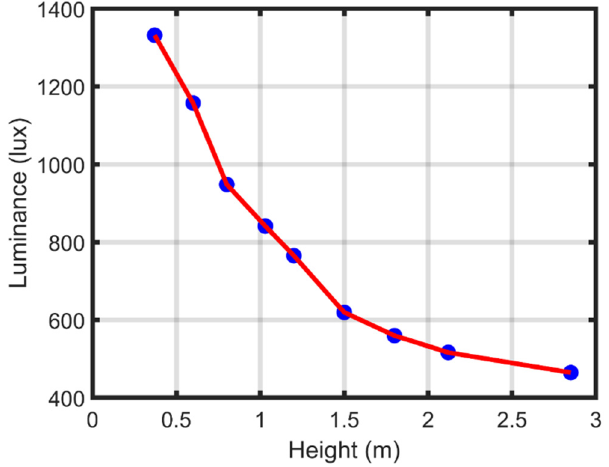
Figure 6. LED light intensity distribution ( 𝜇 = 0, 𝜎 = 54.1218).